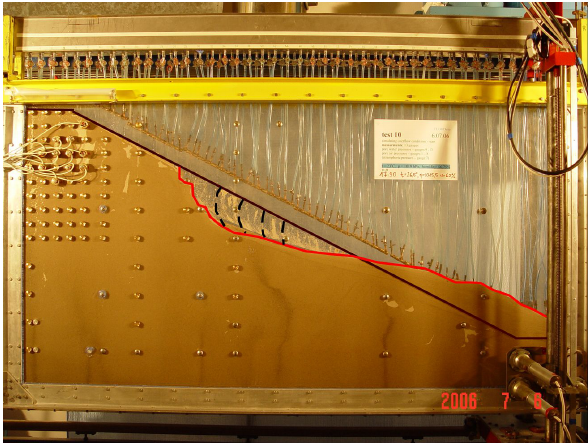
Figure 5: Embankment destruction mechanism (type 1 model) - test F10 - test using a rain generator with a water outlet of qi ~ 10